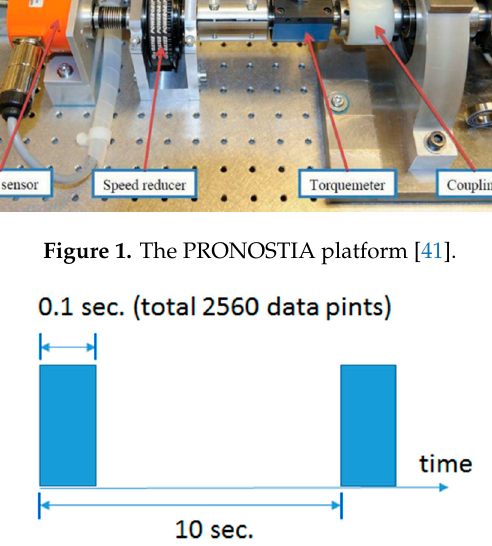
Figure 2. The data acquisition of the vibration sensor lasts for 0.1 s per 10 s.